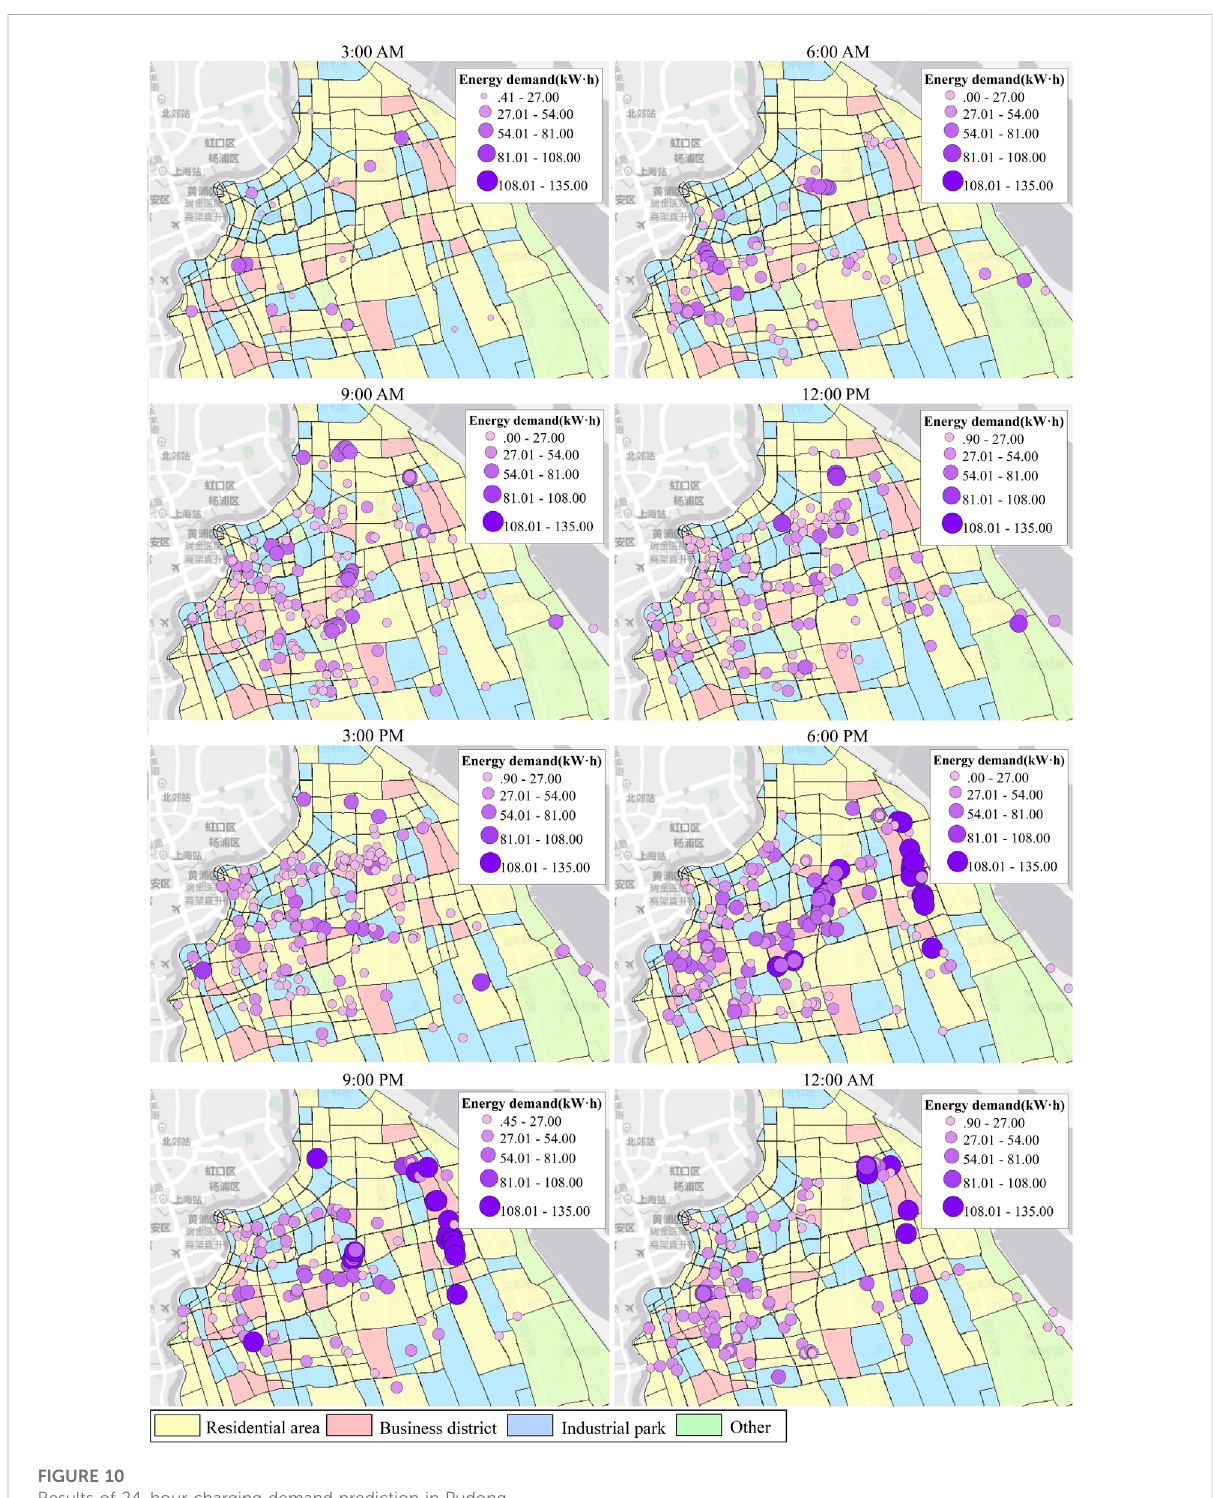
FIGURE 10 Results of 24-hour charging demand prediction in